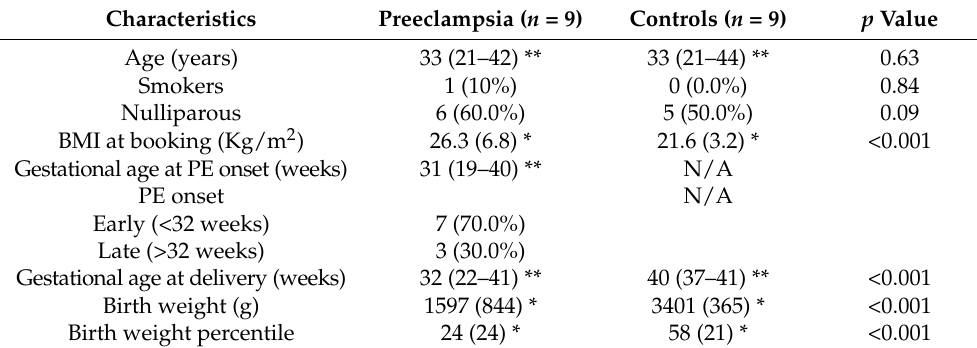
Table 1. Characteristics of patients enrolled in the study.